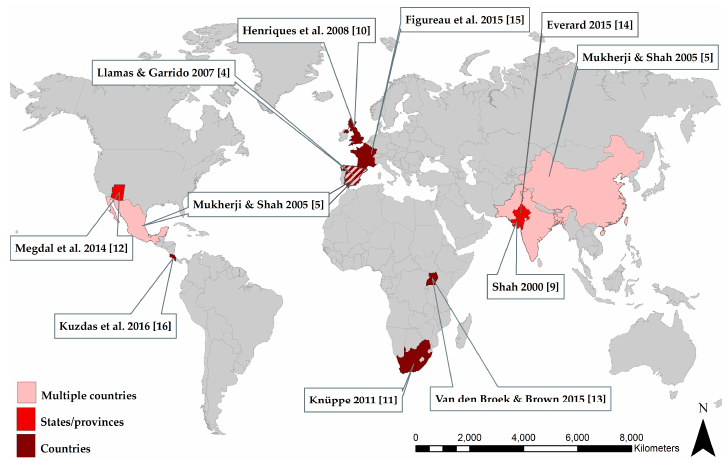
Figure 1. Location of case studies. This map illustrates the diversity of the geographic location of the case studies analyzed in this paper.